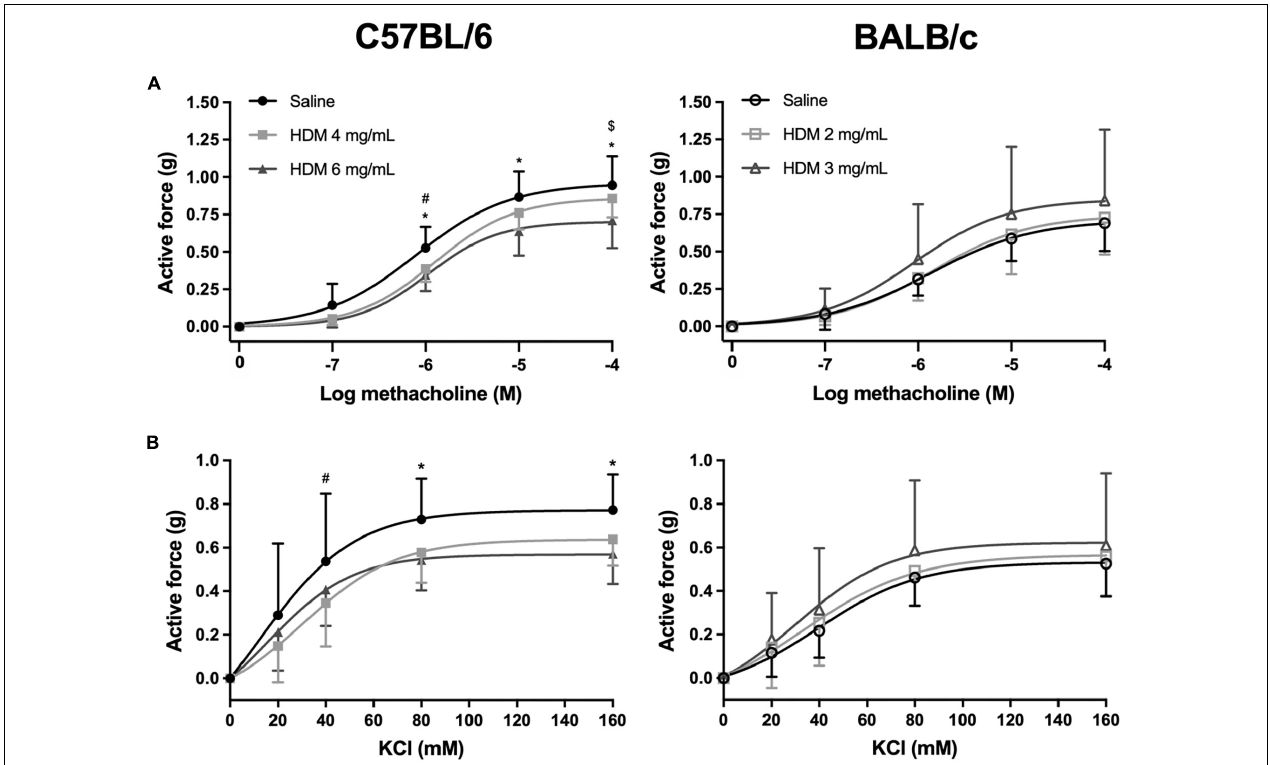
FIGURE 3 | The contractile capacity of excised tracheas derived from C57BL/6 (left panels) and BALB/c (right panels) mice exposed to either saline or one of two doses of HDM. The graphs in (A,B) show the isometric force generated by the tracheas in response to increasing concentrations of methacholine and potassium chloride, respectively. *, #, and $ designate significant differences in C57BL/6 for saline vs. HDM 6 mg/mL, for saline vs. HDM 4 mg/mL, and for HDM 6 vs. 4 mg/mL, respectively ( P < 0.05). Data are shown as means ± SD. n = 10 mice per